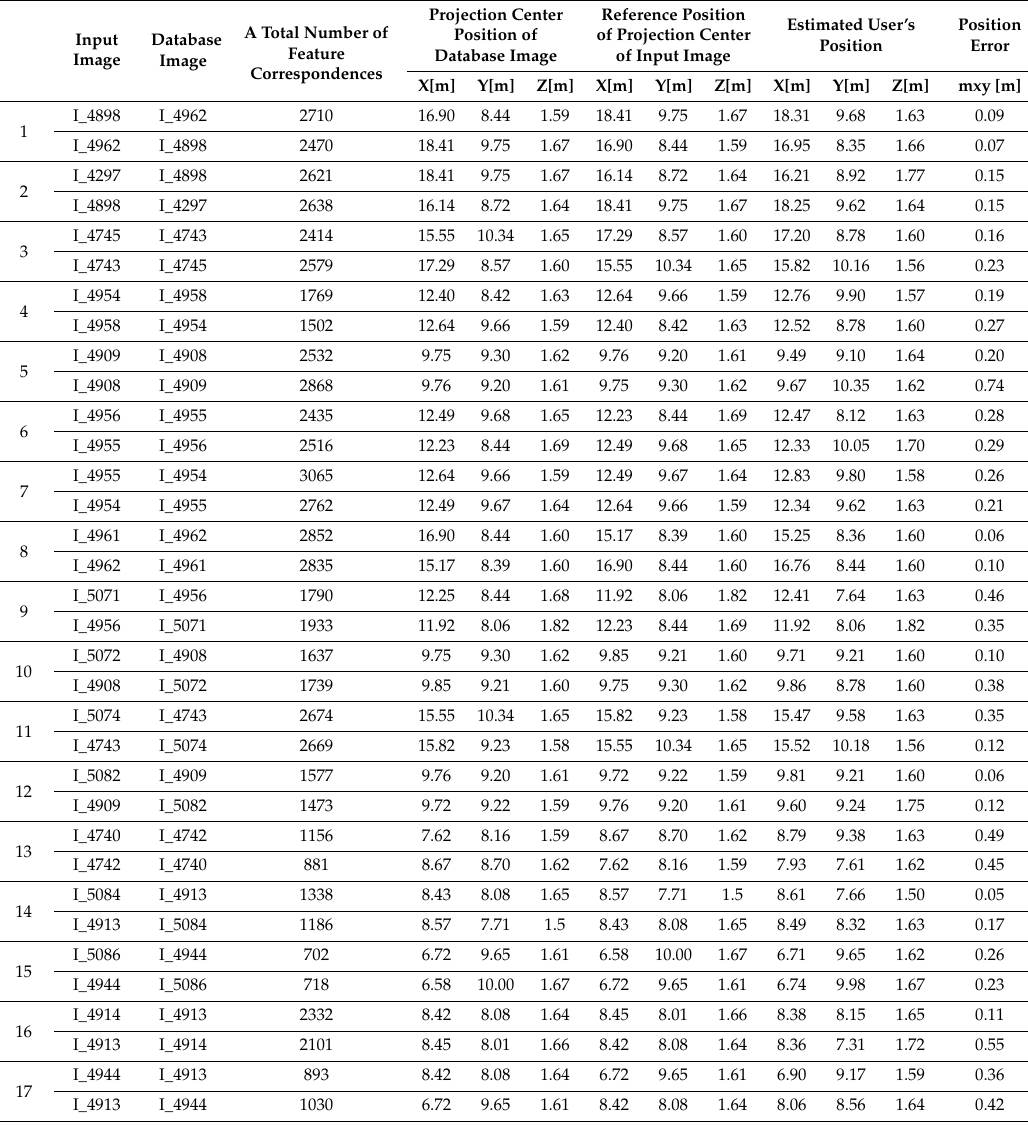
Table 1. Results